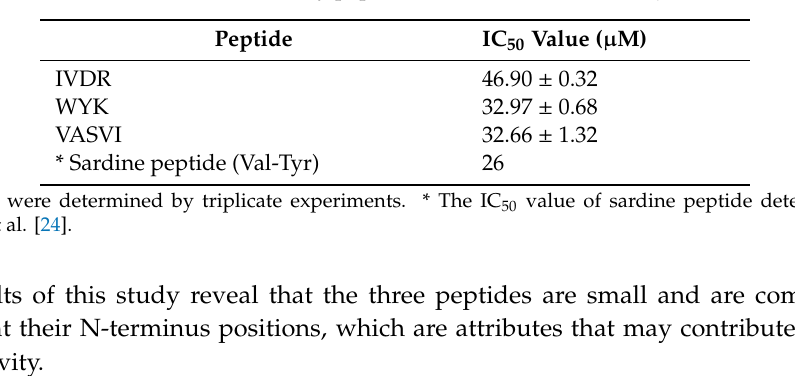
Table 1. IC 50 values of ACE inhibitory peptides derived from Paralichthys olivaceus